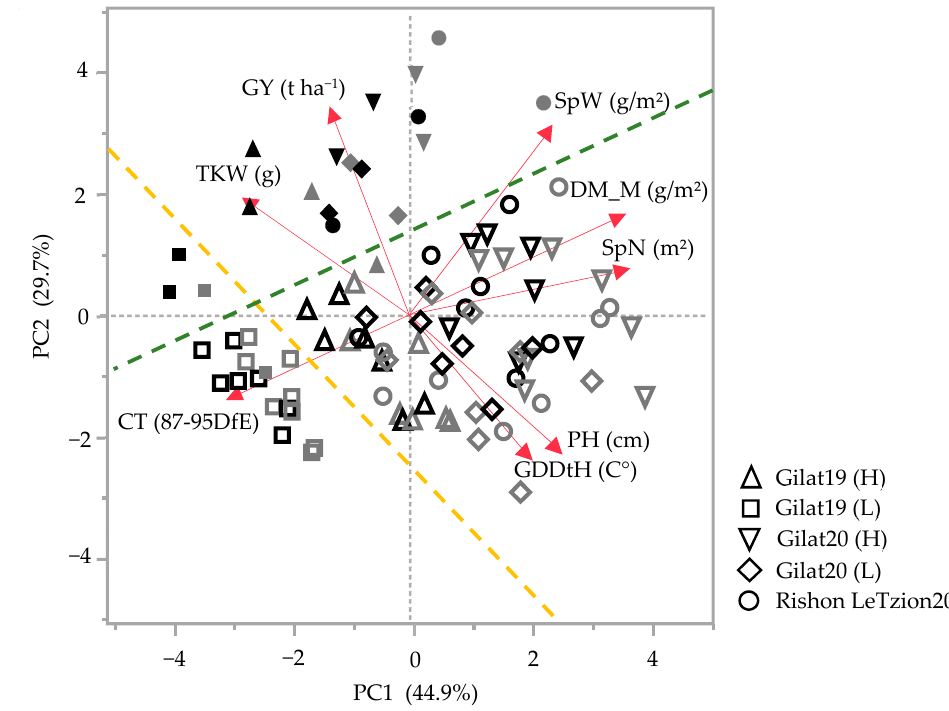
Figure 1. Principal component analysis of agronomic traits under five environments across two seasons, 2018–2019 and 2019–2020. Modern bread wheat cultivars (solid gray symbols), modern durum cultivars (solid black symbols), bread wheat landraces (hollow gray symbols), and durum wheat landraces (hollow black symbols). Biplot vectors are trait factors loading for PC1 and PC2. GY, grain yield; SpW, spike weight; DM_M, dry matter at maturity; SpN, spike number; PH, plant height; GDDtH, growing degree days to heading; CT, canopy temperature; and TKW, thousand kernel weight. Green dashed line separates the modern cultivars from the landraces (with two exceptions). Yellow dashed line separates Gilat19 (L) from the rest of the environments. Table 1. Analysis of variance for the effects of genotype group (G), environment (E), and their interactions (GXE) for phenotypic traits: growing degree days to heading (GDDtH), canopy temperature (CT), plant height (PH), grain protein content (GPC), thousand kernel weight (TKW), dry matter during maturation (DM_M), spike number (SpN), grain number (GN), and harvest index (HI). d.f. Source of Variance